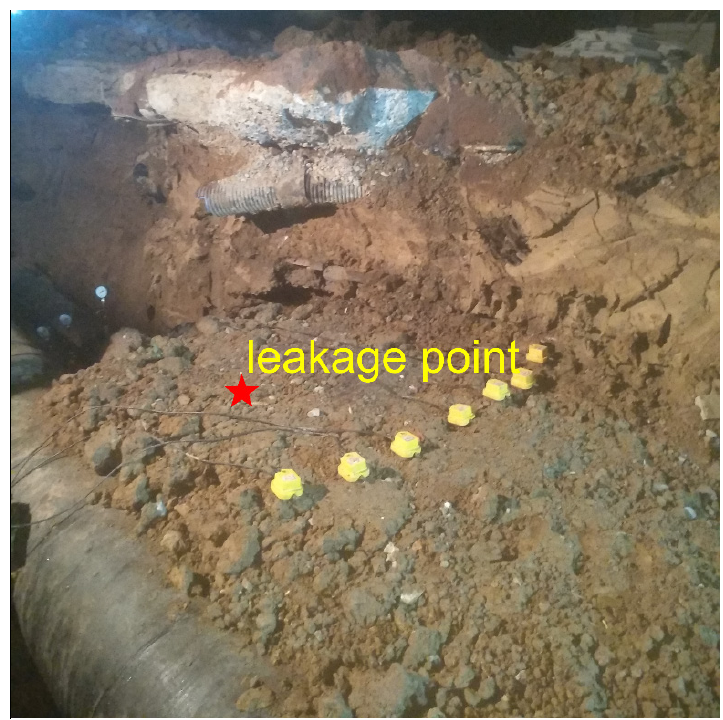
Figure 6. Ground surface vibration measurement using the sensor array at the distance of 1 m from the leak.